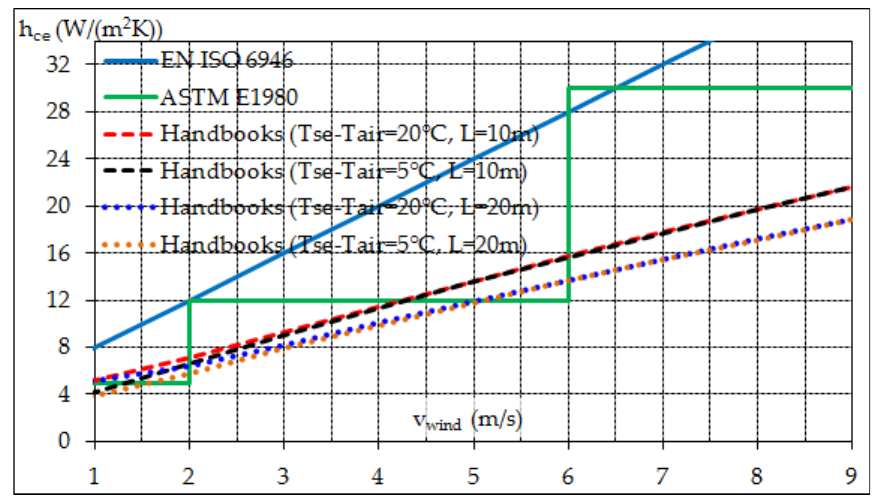
Figure 7. Convection coefficient vs. wind velocity according to different estimation methods.